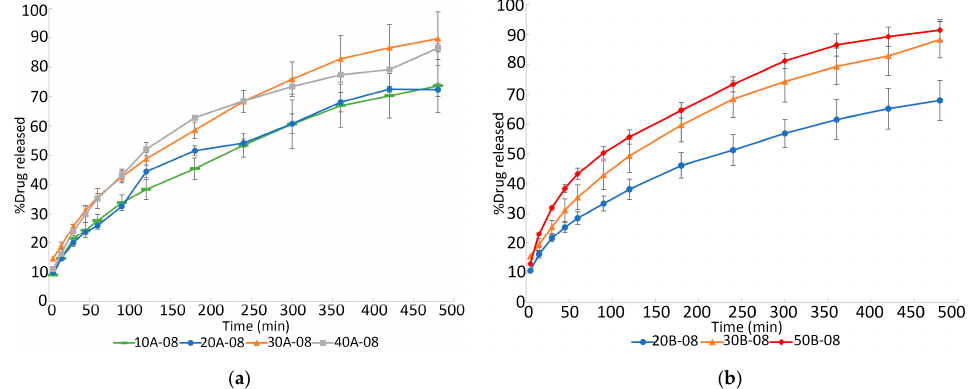
Figure 5. Effect of drug load on the in vitro dissolution of 3D 3DP tablets: ( a ) 5% of each auxiliary excipients; ( b ) 7.5% of each auxiliary excipient.